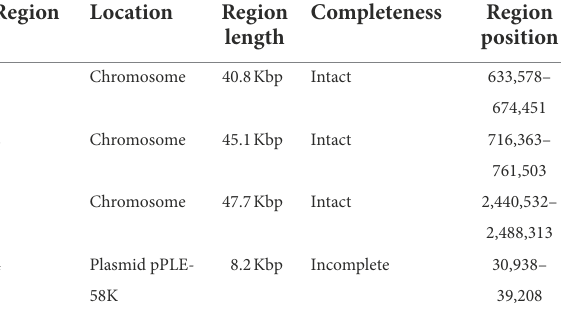
TABLE 1 Potential prophages detected in L. pentosus 9D3 genome. Region